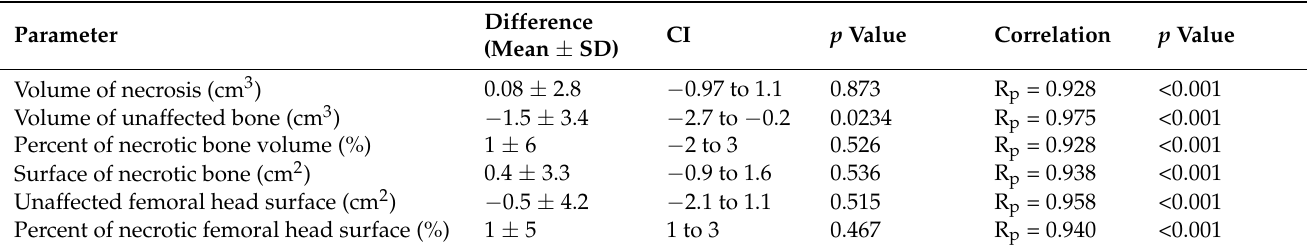
Table 3. Comparison of the manual segmentation of femoral head necrosis on 3D MRI with the manual segmentation of 2D MRI.